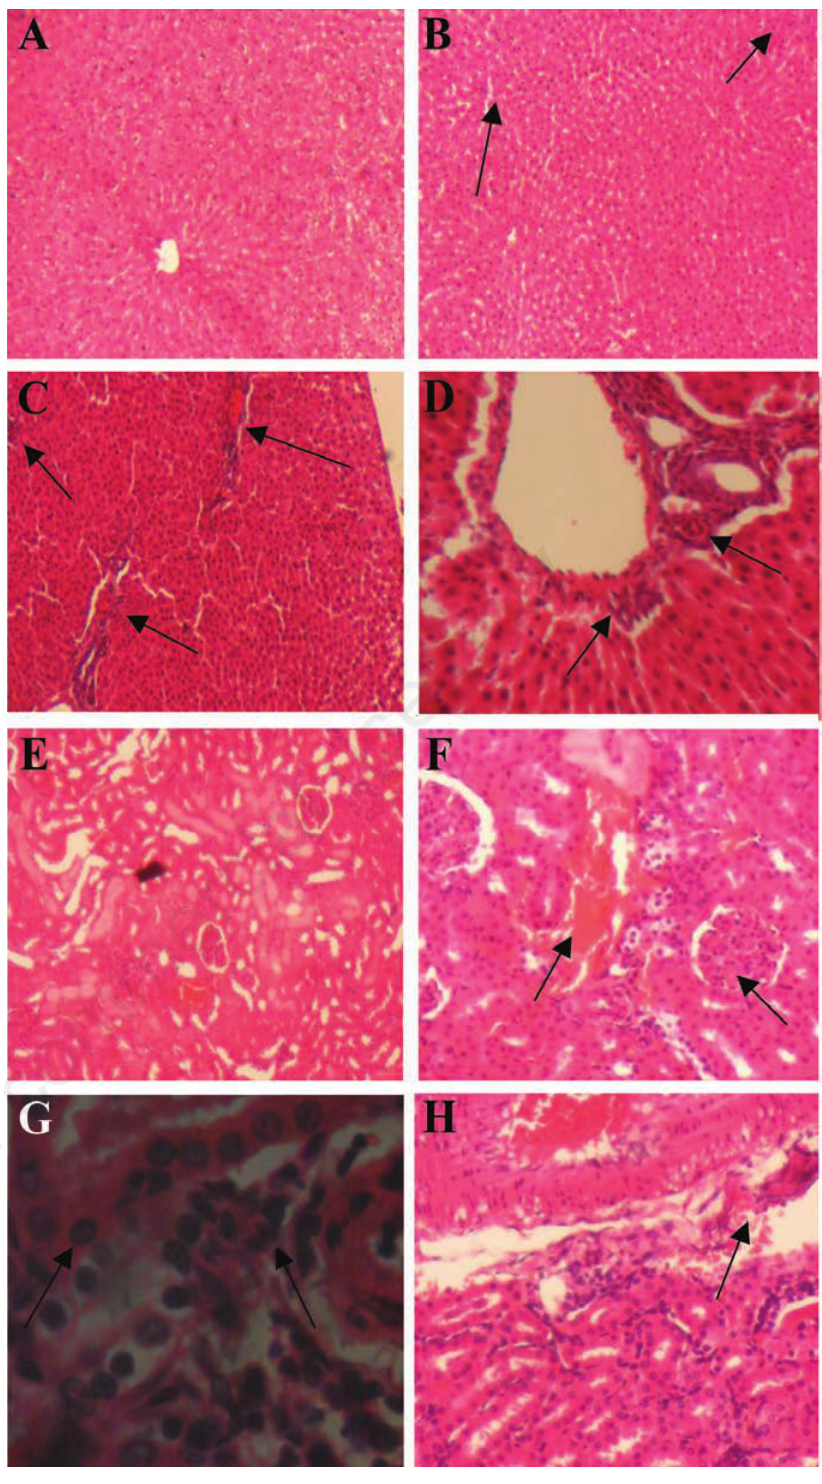
Figure 2. Histopathological examination: section of rat liver tissues showing normal archi- tecture in the control group (A); hepatocytes of rats treated with 100 mg/kg of Solignum ® (B) showing mild inflammatory infiltrate; section of the rat liver tissues treated with 200 mg/kg of Solignum ® showing inflammatory cells (C) and 400 mg/kg of Solignum ® (D) showing mild periportal inflammation and cytoplasmic degeneration; section of the rat kidney tissues of control rats (E) showing normal architecture and rats treated with 100 mg/kg of Solignum ® showing inflammatory cells and congested vessel (F); rat kidney tis- sues treated with 200 mg/kg body weight of Solignum ® showing inflammatory cells (G) and 400 mg/kg of Solignum ® showing interstitial hemorrhage